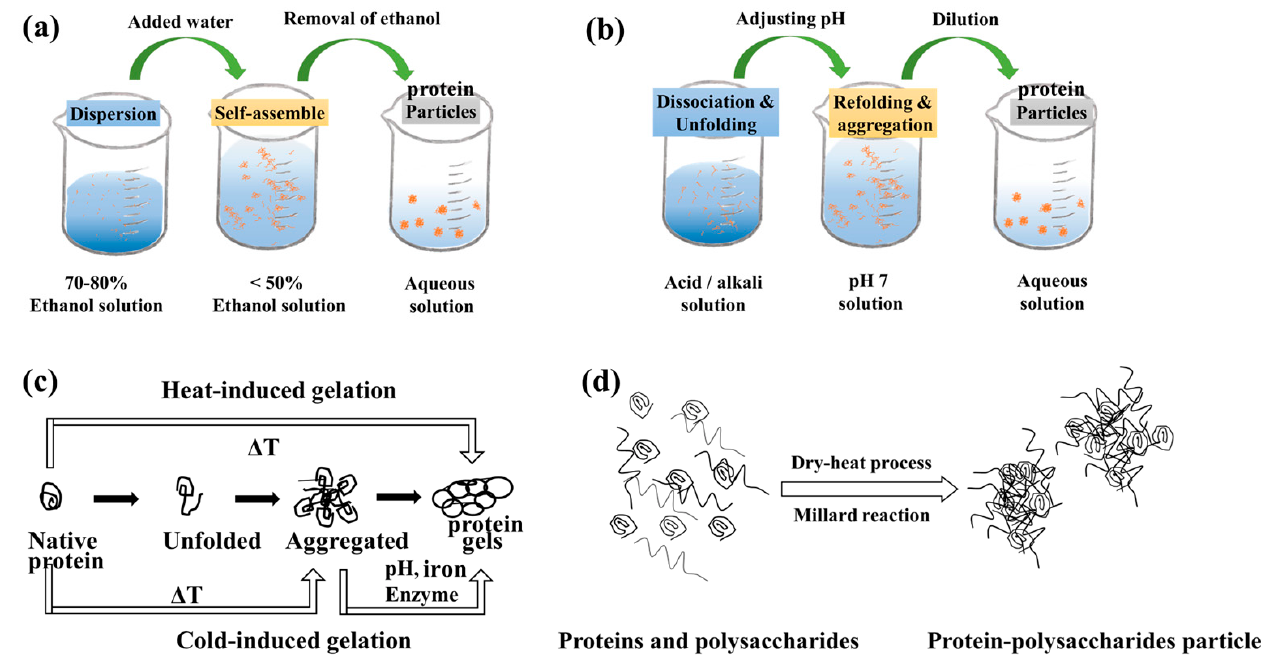
Figure 6. Main approaches and mechanisms for protein stabilizer preparation: ( a ) alcohol-soluble protein pretreatment; ( b ) preparation of HIPE stabilizers by pH adjustment method; ( c ) gelation process; ( d ) binding of proteins and polysaccharides by Maillard reaction.